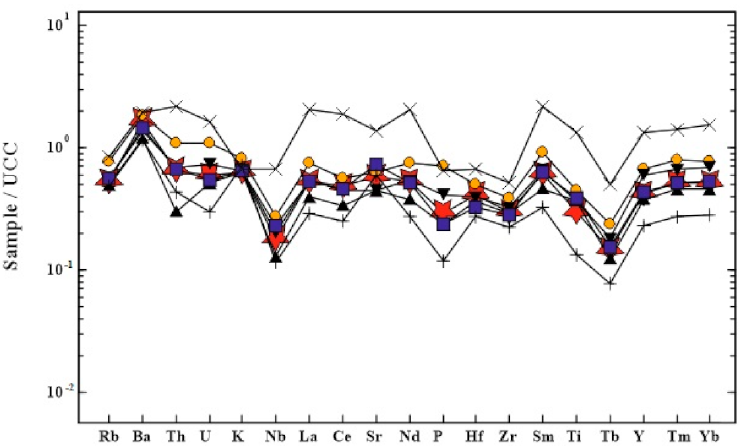
Figure 8. Trace elements of the samples vs UCC concentrations. (UCC normalization after [26]). Symbols as in Figure 5.